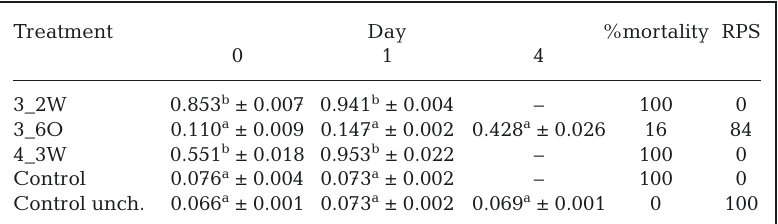
Table 3. Effect of surface-associated bacteria on anti- Vibrio antibody titres in brown-marbled grouper fingerlings after a challenge with pathogenic V. harveyi in a bio-control rearing system. %mortality count from 25 fingerlings per group in 3 replicates, and relative percent of survival (RPS) calculated as 1 − %mortality. Bacterial isolates—3_2W: Vibrio harveyi ; 3_6O: Exiguobacterium acetylicum ; 4_3W: Psychrobacter sp. –: all fingerlings dead, no measurement possible. Differ- ent superscript letters within the same column indicate a significant difference among the treatments according to the Tukey’s test (p < 0.05). Control: no pre- treatment but challanged; control unchallenged: no pre-treatment, not challenged (negative control). Mean ± SE